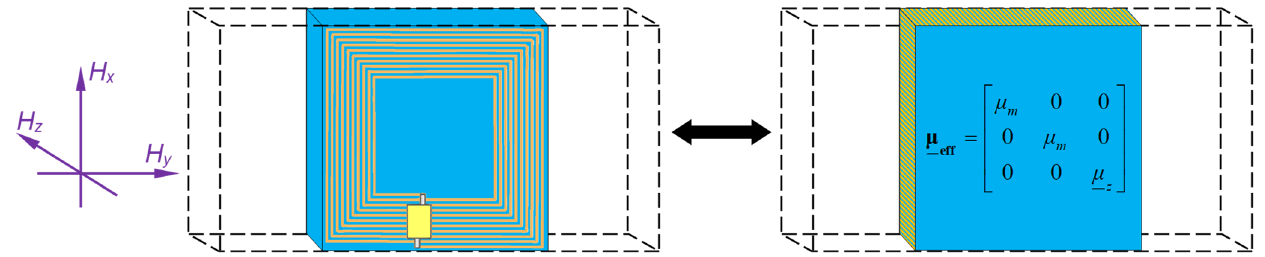
Figure 2. An exemplary cell of the considered anisotropic metamaterial: the meta-cell acts as an anisotropic, homogenous medium characterized by the complex effective permeability tensor µ eff .